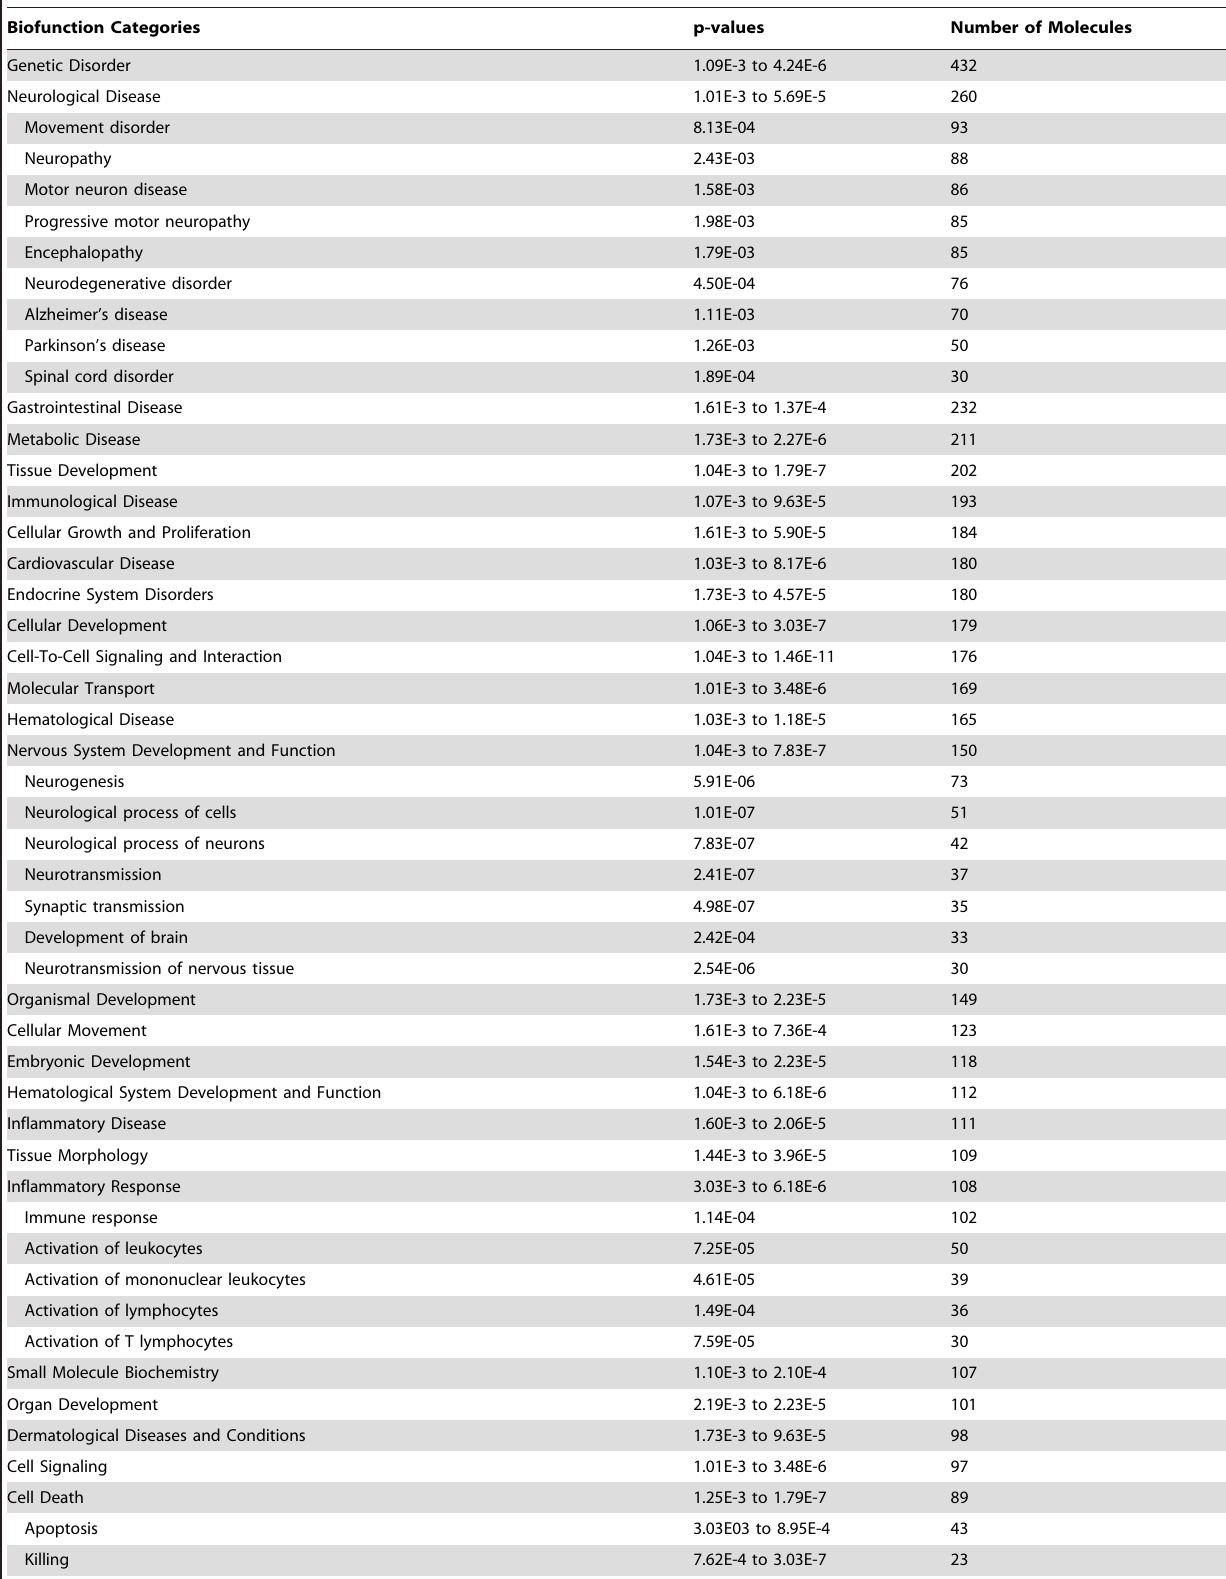
Table 3. Significant biofunctions (p , 0.0001) enriched by more than 50 candidates from the 1,142 genes of interest